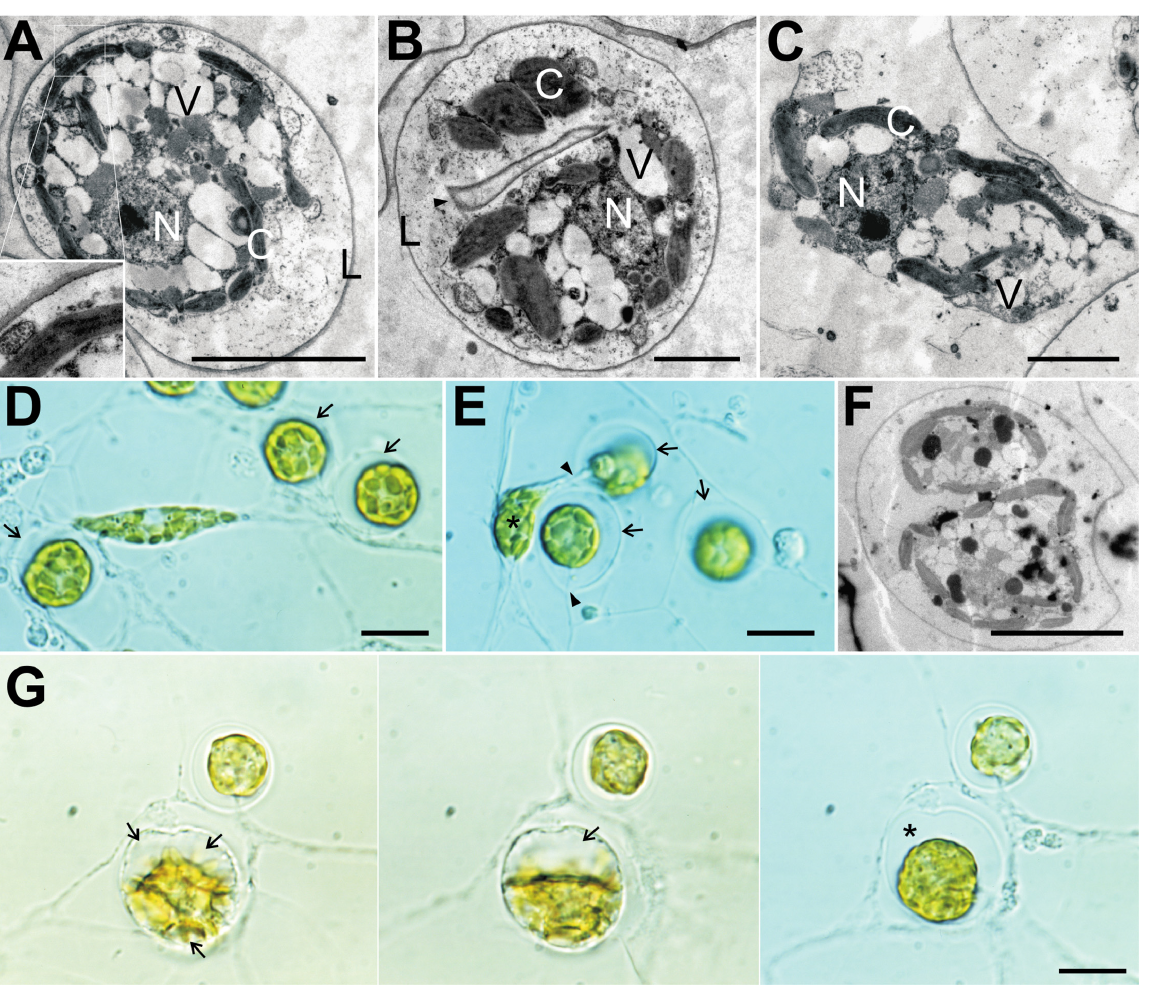
Fig 3. Morphology of Chrysopodocystis socialis . (A) TEM of sessile amoeba encased in a thin lorica. Central nucleus surrounded by multiple vacuoles. Parietal chloroplasts are pressed against the cell membrane. (B) TEM of one amoeba in a lorica during cytokinesis with a diaphragm-like structure (arrowhead). (C) TEM of migrating amoeba moving between two loricae. Chloroplasts are flattened against the cell membrane. (D+E) Migrating amoeba with leading and trailing filopodium. Chloroplasts are randomly distributed in the cell and the nucleus positioned in the center. Sessile amoebae encased in globular, hyaline loricae (arrows). After binary division, one daughter cell (asterisk) leaves the lorica through the ostiole (arrowhead). In some focus planes, the short rim of the ostiole is visible. (F) TEM of two sessile amoebae in one lorica after binary division. (G) Sequence of lorica formation from establishment of multiple vacuoles (left, 9:55 PM), the fusion into one vacuole (center, 10:30 PM), to the complete reduction of vacuoles and the re-establishment of a connection to the meroplasmodium (right, next day 4:45 PM). The final lorica is considerably larger than the MCB, leaving room (asterisk) for expansion during cell growth. Scale bars A, F: 5 μ m, B, C: 2 μ m, D, E, G: 10 μ m. C — chloroplast, N — nucleus, L — lorica, V — vesicle.